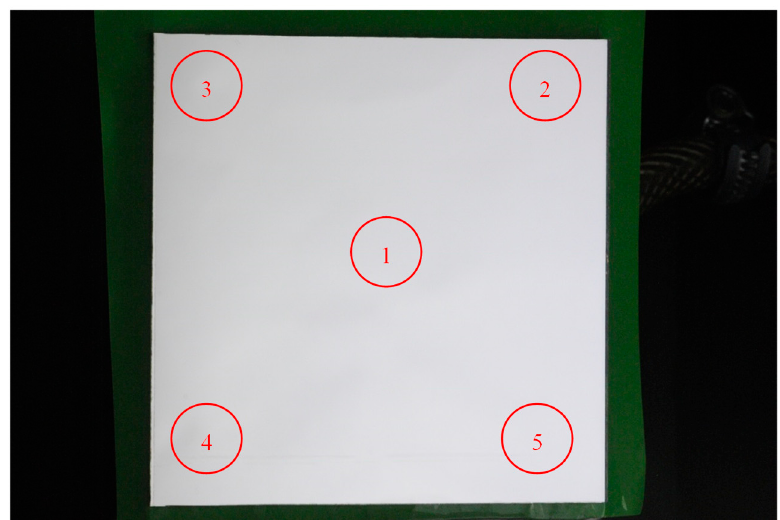
Figure 4. Five spots measured on each reflector sample with the reflectometer, according to the conventional measurement technique.